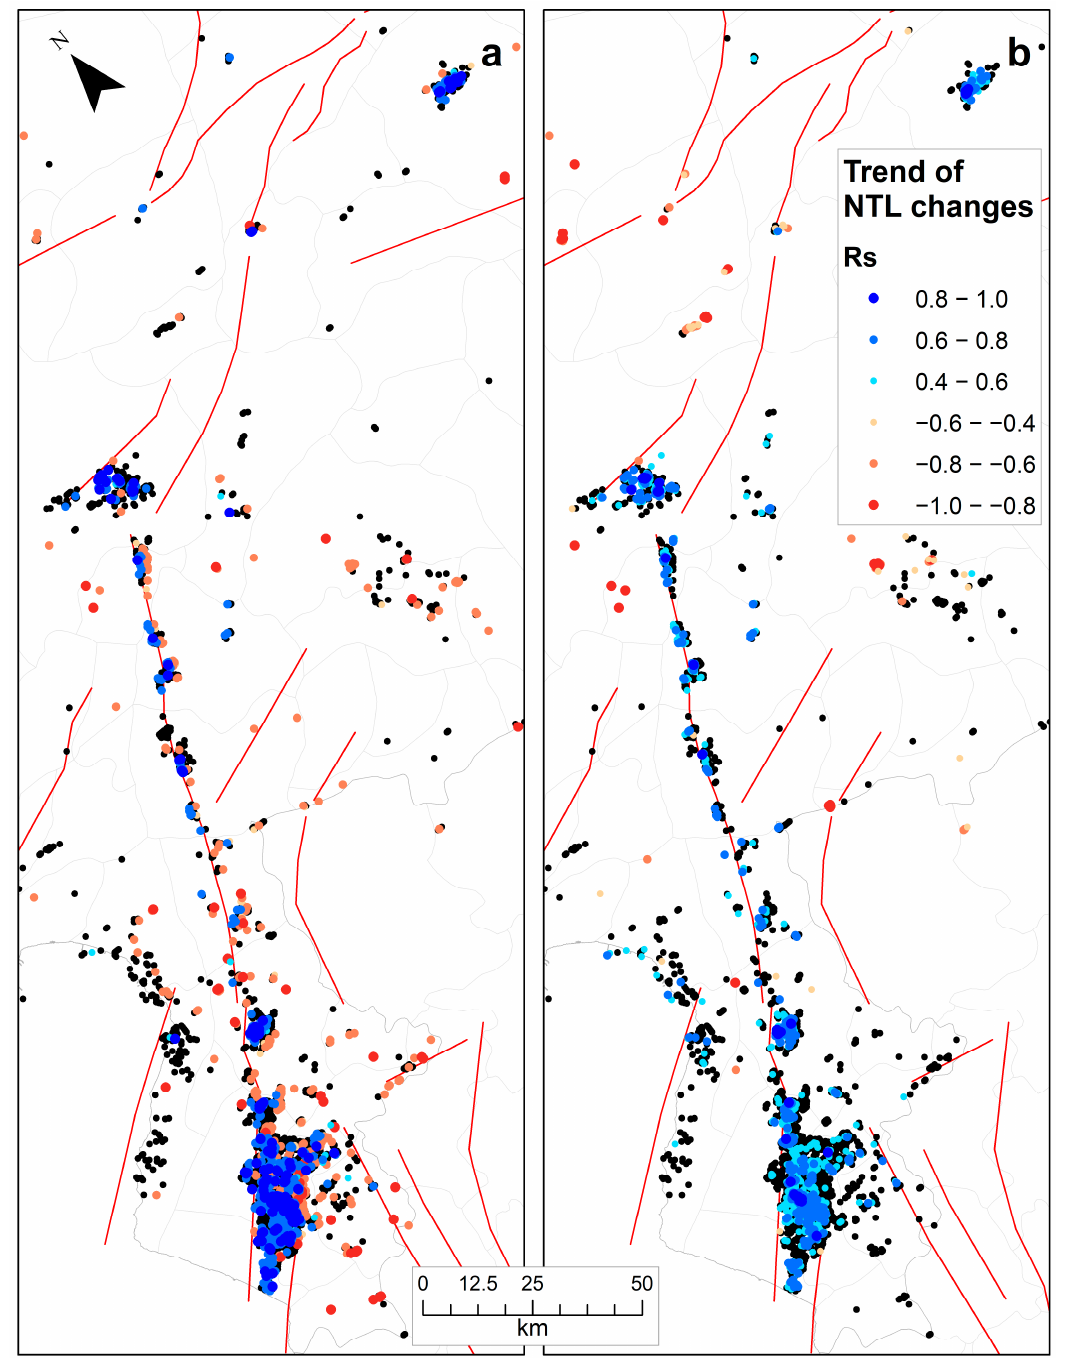
Figure 10. Recovery of NTL in lit VIIRS grid cells (colored dots) based on time series of VIIRS data, as computed using Spearman’s rank correlation coe ffi cient for two time periods following the earth- quakes: ( a ) 7–19 February 2023; ( b ) 7 February–2 March 2023. Black dots represent VIIRS lit grid cells in which there were statistically signi fi cant decreases in NTL following the earthquakes but no recovery was detected over the time period shown.